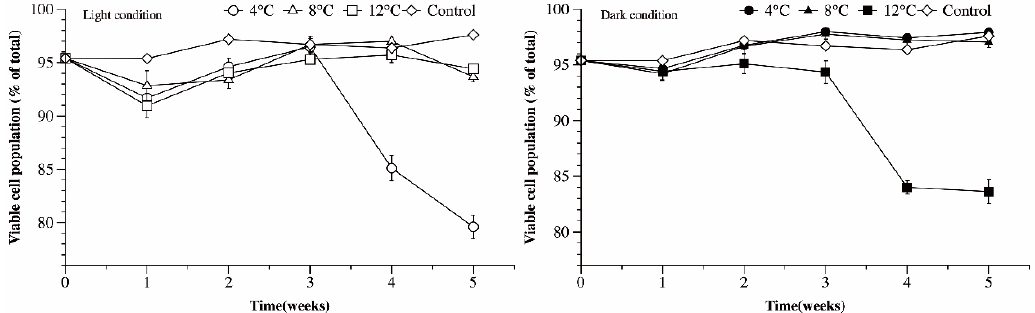
Figure 5. The ratio of undamaged cells to the sum of damaged and undamaged cells at different temperature and light conditions.